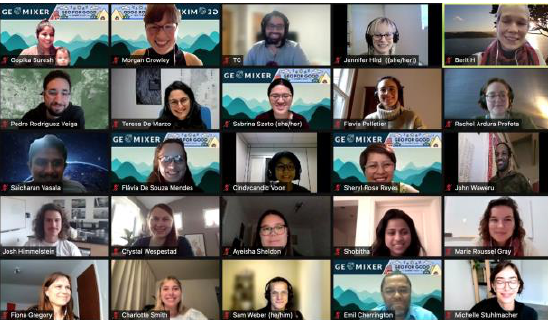
Figure 4. The participants of the GeoMixer hosted in the Geo for Good Summit